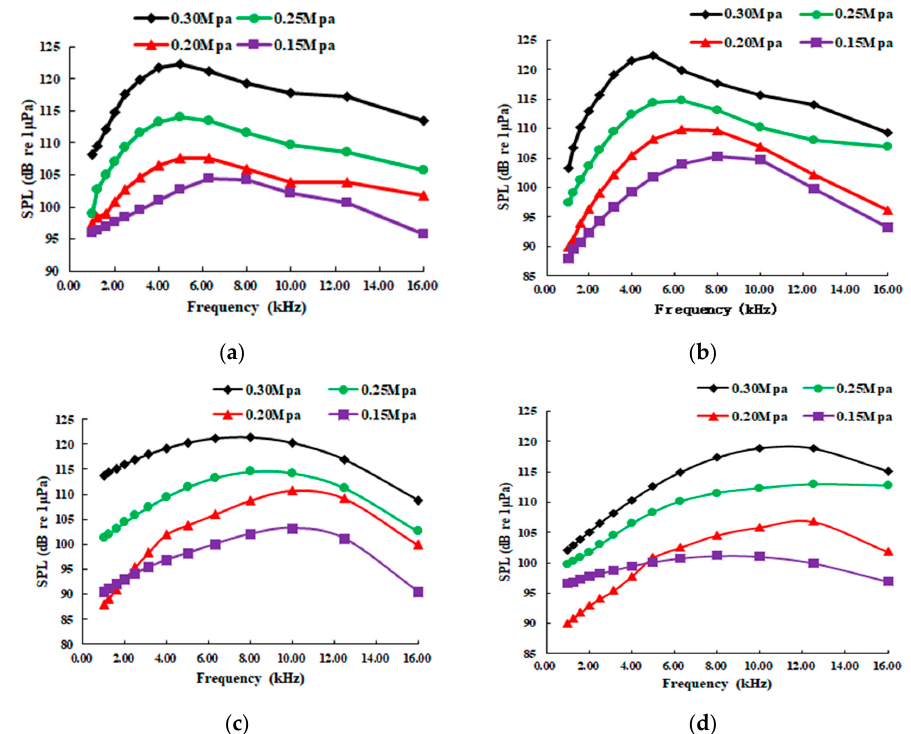
Figure 15. Radiated sound pressure levels under different leakage pressure. (a) DN25; (b) DN20; (c) DN15; (d) DN8.